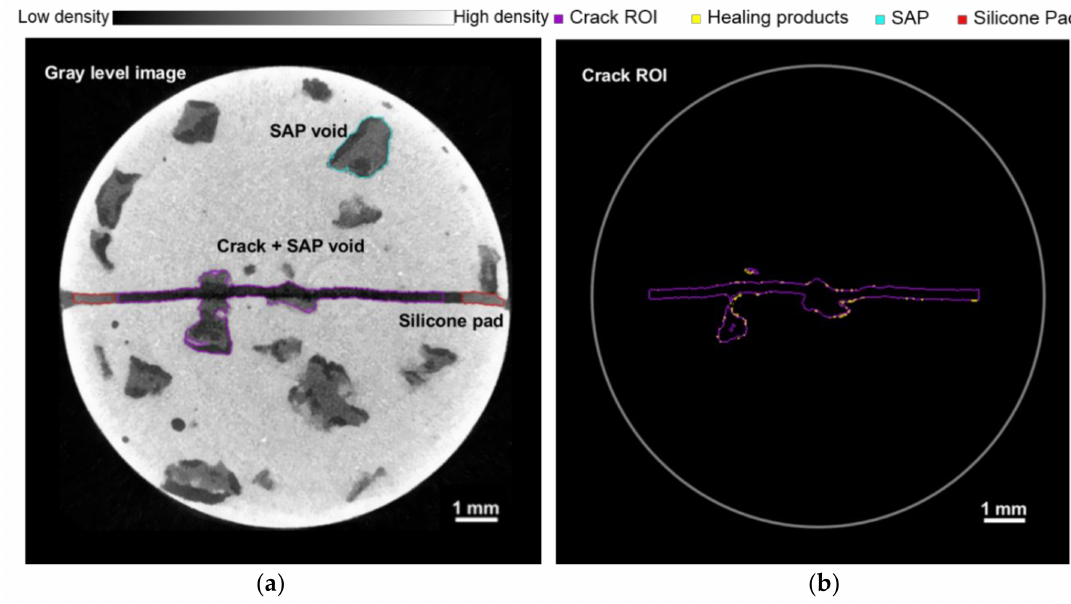
Figure 10. ( a ) Gray-level X-ray micro CT image of specimen. Crack regions of interest (ROI) includes the crack and directly connected SAP voids is shown in purple, the silicone pad in red, and SAP voids in blue; ( b ) The crack ROI (purple) and healing products